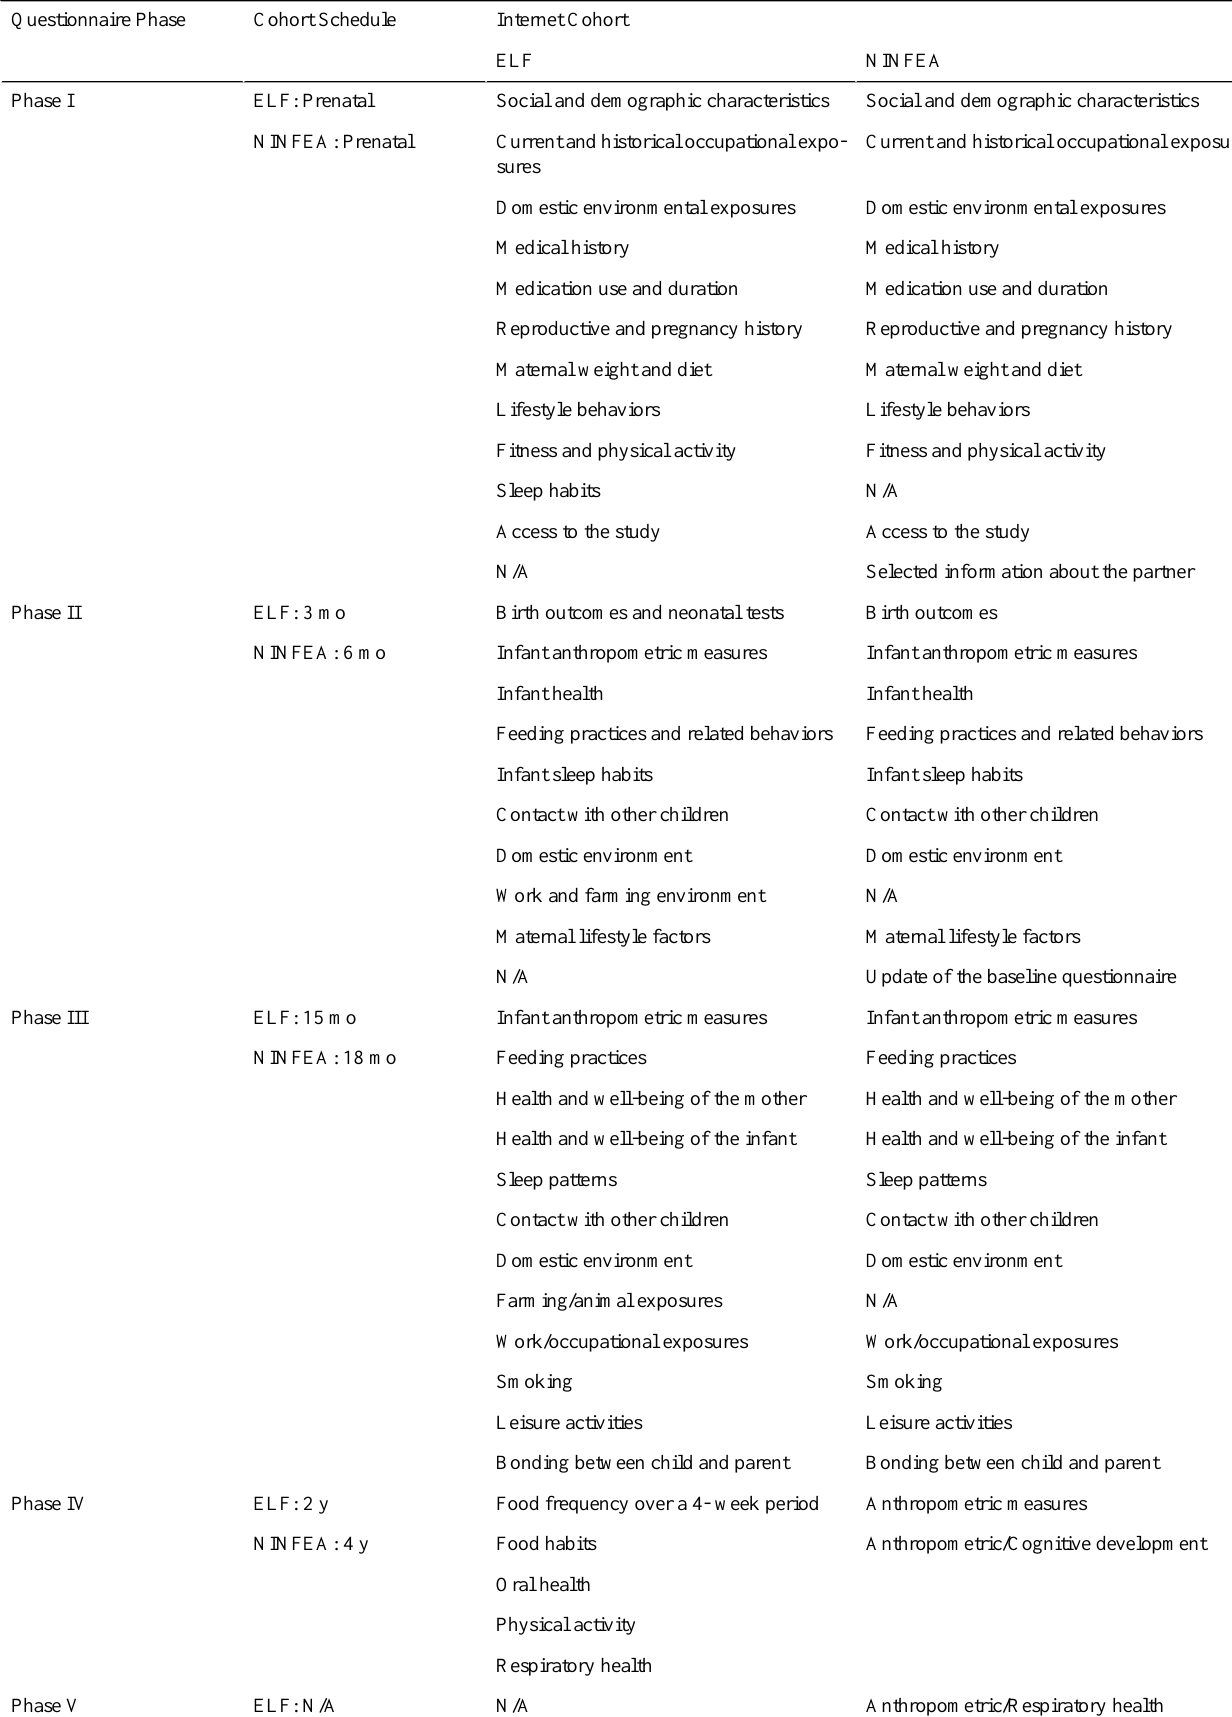
Table 1. Schedule of questionnaire phases, by Internet